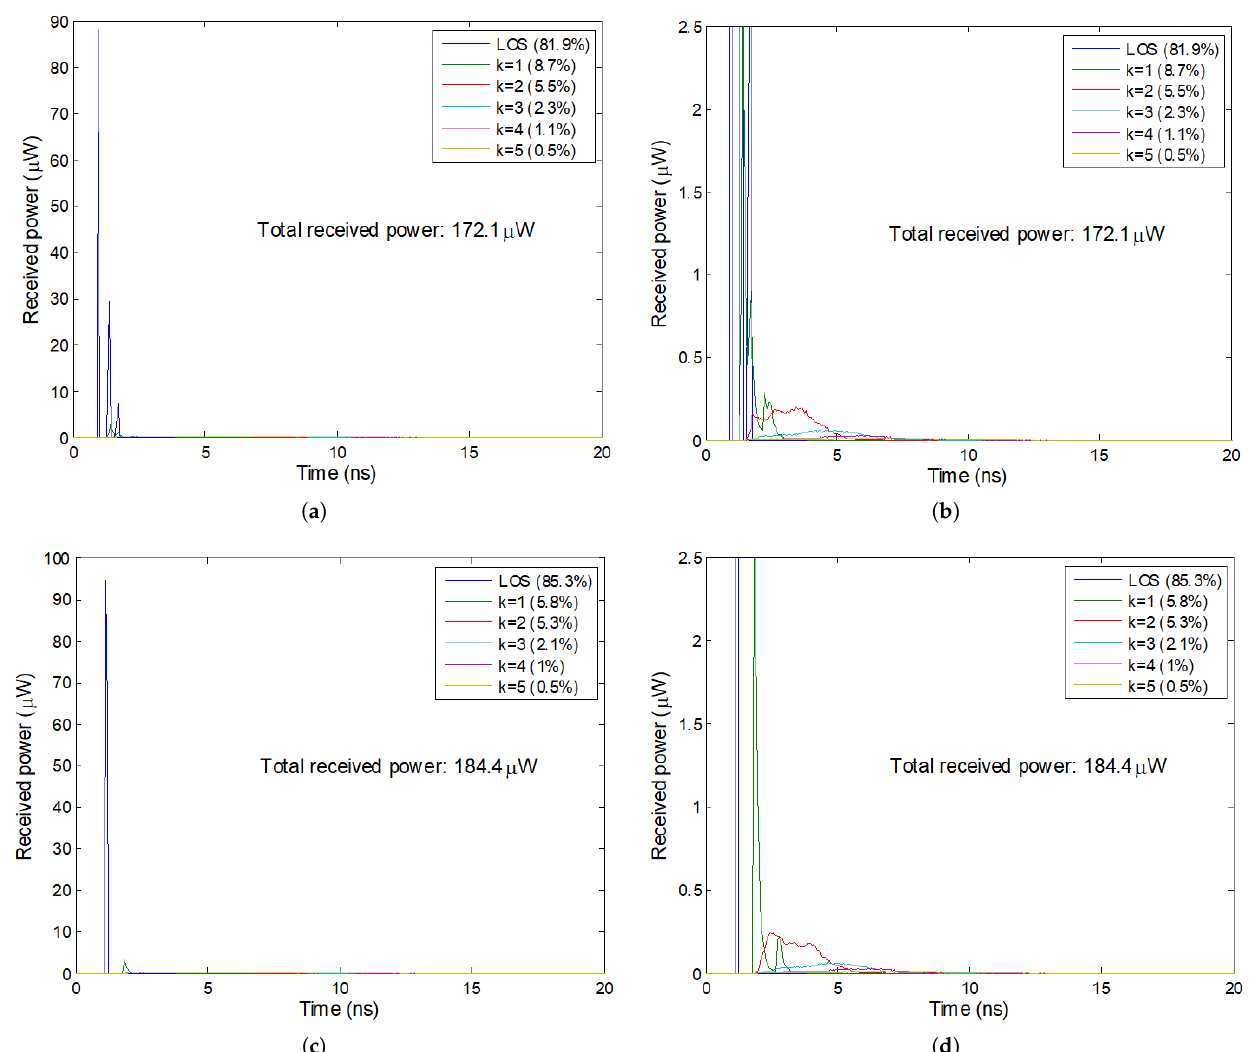
Figure 10. Simulated impulse responses at two locations of the mockup: ( a ) Impulse response under lamp 1 (close to a window). ( b ) Zoom of impulse response under lamp 1. ( c ) Impulse response at the center of the mockup. ( d ) Zoom of impulse response at the center of the